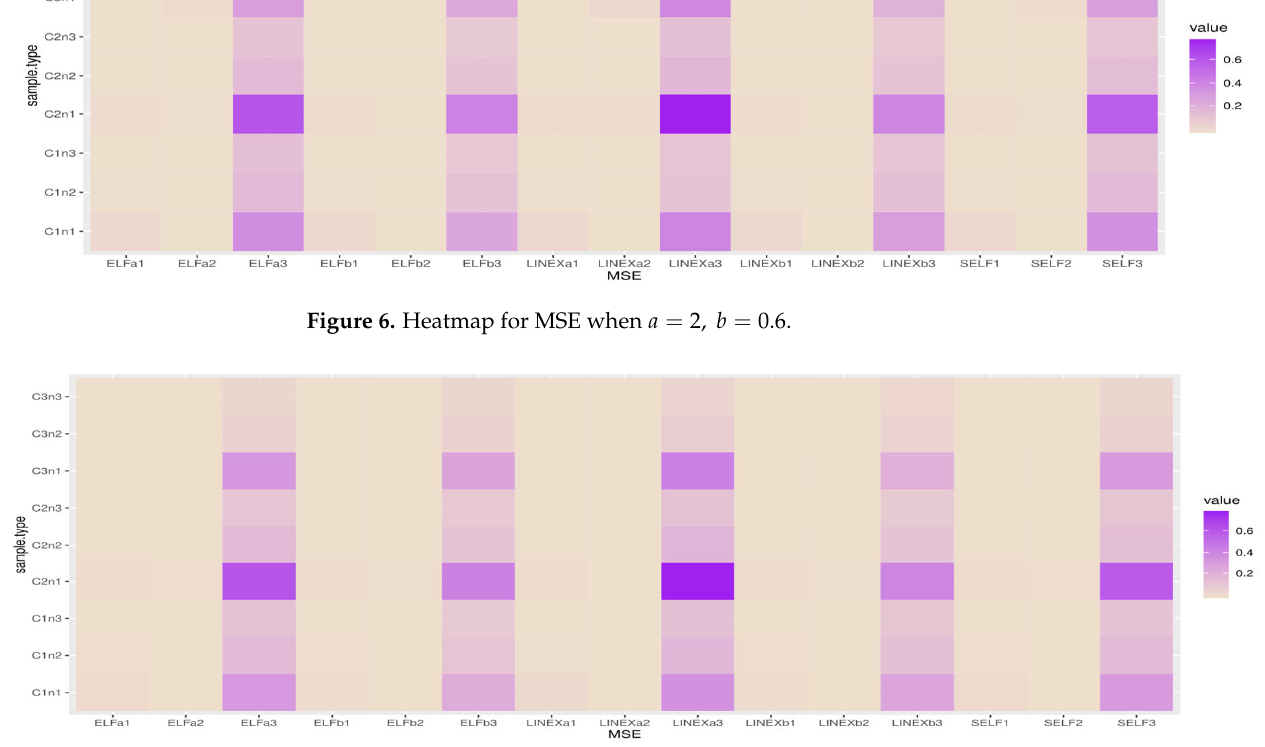
Figure 7. Heatmap for MSE when 𝑎 (cid:3404) 2, 𝑏 (cid:3404) 1.7 .